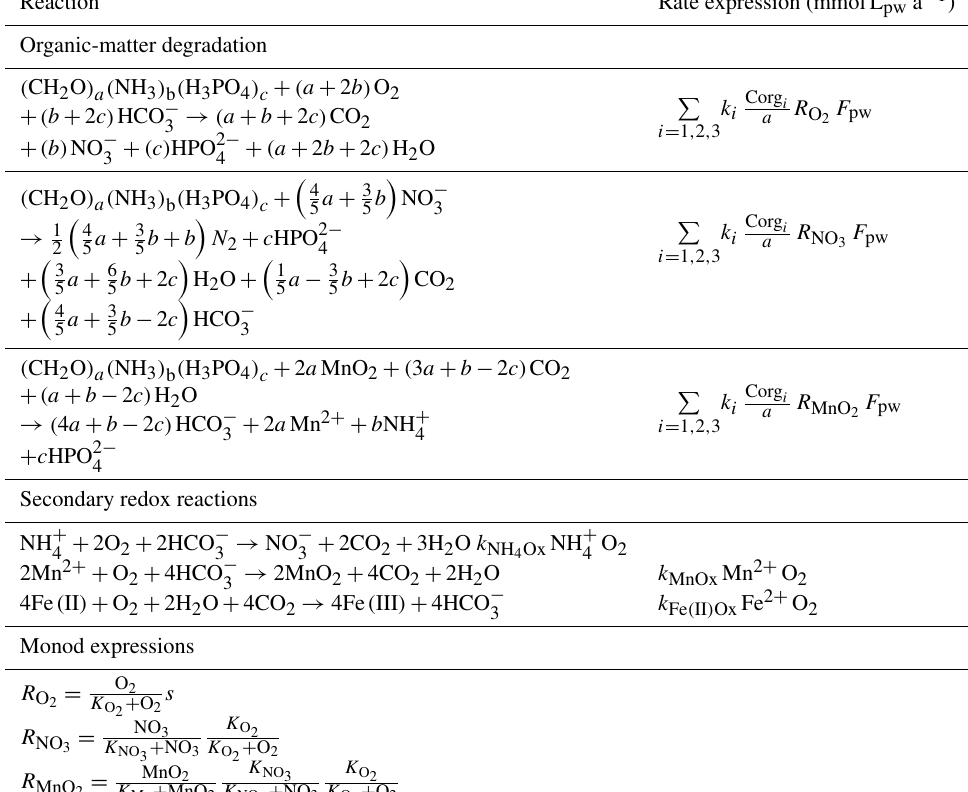
Table 3. Reaction stoichiometry and rate expressions of the organic mater ( ( CH 2 O ) a ( NH 3 ) b ( H 3 PO 4 ) c ) degradation and secondary redox reactions. All solute species are in concentrations of millimoles per litre of porewater (mmolL − 1 pw ) and all solid species in millimoles per litre of dry sediment (mmolL − 1 ). All reaction rate expressions are stated (in the units of mmolL − 1 pw a − 1 ) via a conversion with F pw = ds